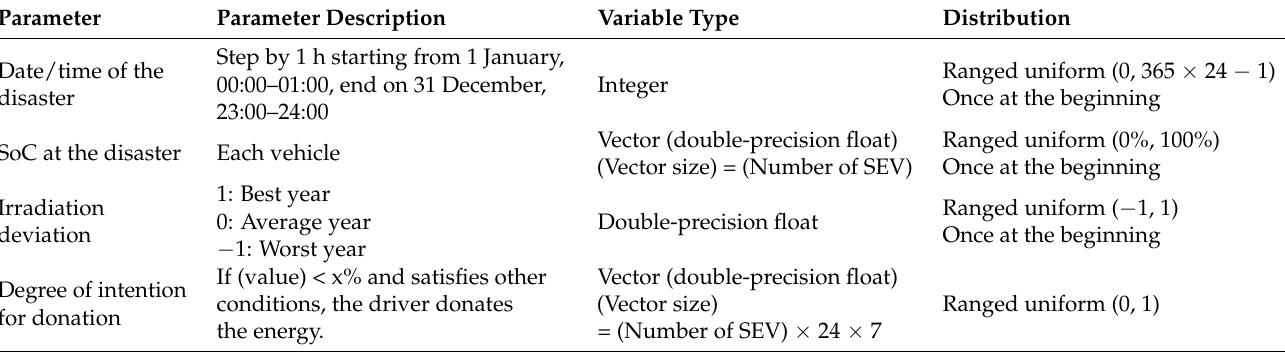
Table 4. List of probability parameters and values used for the Monte Carlo